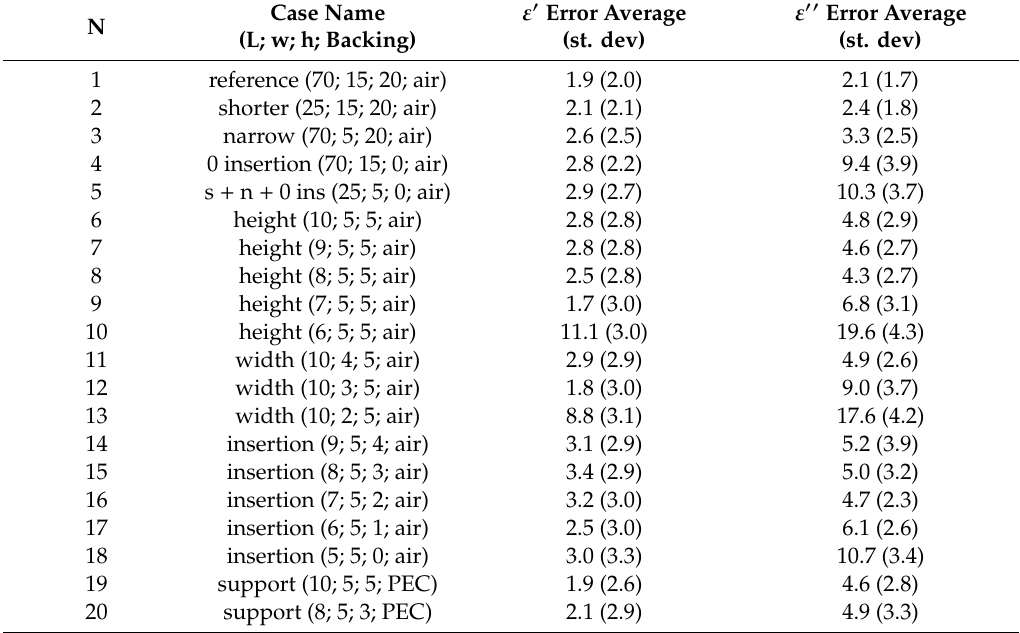
Table 2. Average errors achieved in the evaluation of the real and imaginary part of the relative complex permittivity of liver in several geometrical